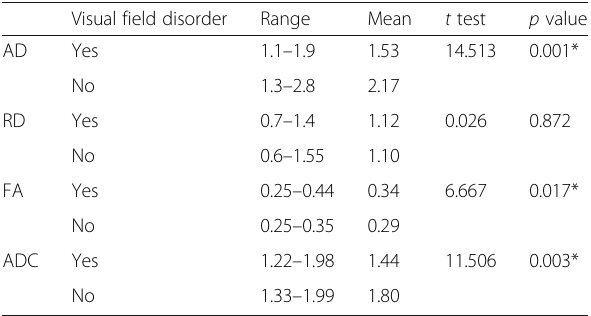
Table 8 A correlation analysis between DTI parameters and visual field disorder Visual field